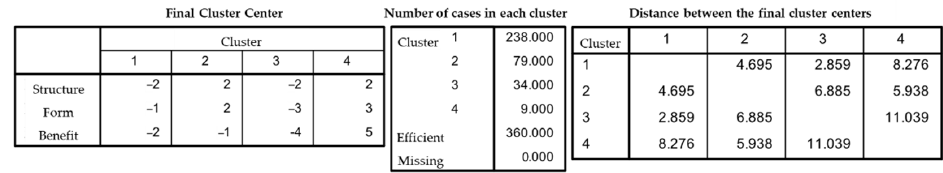
Figure A2. K ‐ means clustering analysis of other buildings before renovation.